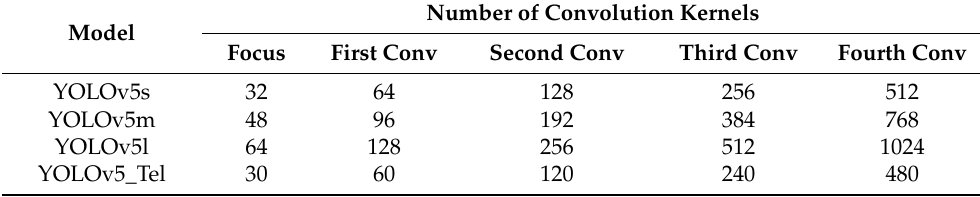
Table 2. Number of convolution kernels in different YOLOv5